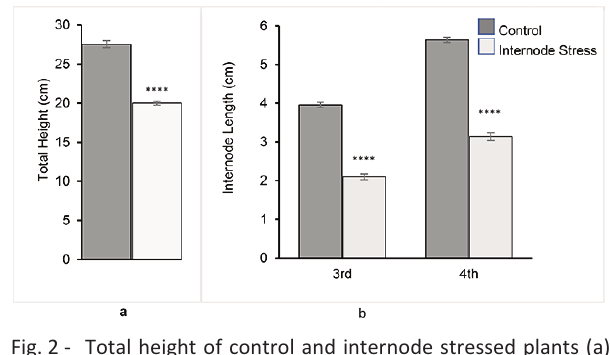
Fig. 2 ­ Total height of control and internode stressed plants (a) and length of third and fourth internode of control and internode stressed plants (b). The vertical bars indicate standard errors. The values correspond to the mean ± SE , where n=20. Statistical analysis was performed by Student’s t­test for total height and internode length. Asterisks indicate mean values significantly differ at P<0.05 (**** indicate P